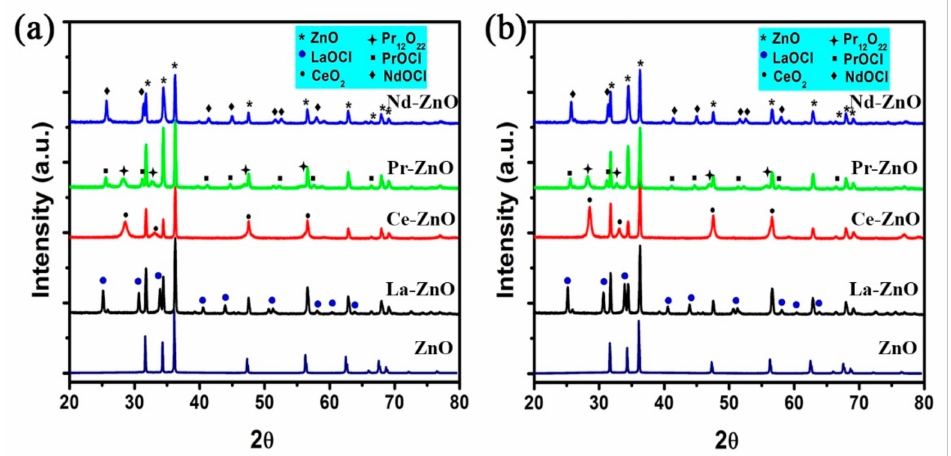
Figure 1. XRD patterns of ZnO and M-ZnO (M = La 3+ , Ce 3+ , Pr 3+ and Nd 3+ ) nanoparticles ( a ) calcined to 500 ◦ C and ( b ) calcined to 700 ◦